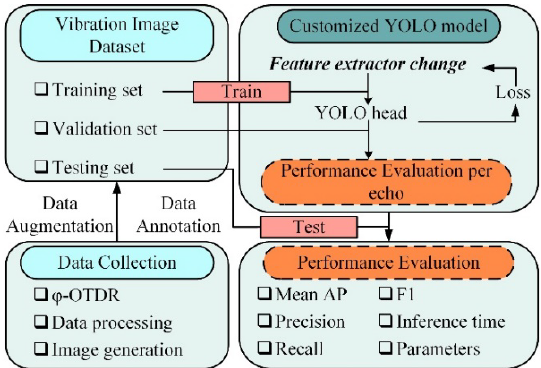
Figure 7. Experimental procedure of the proposed optical fiber sensing vibration identification method based on deep learning.